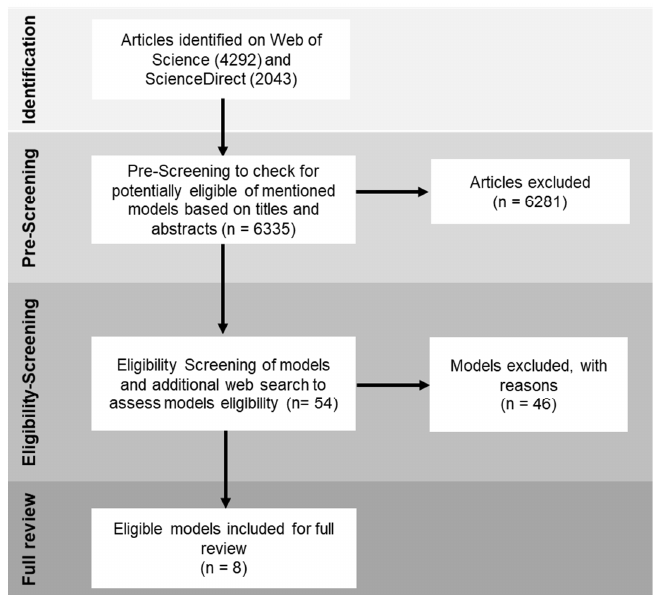
Figure 1. Flow chart of the methods used to identify, assess the eligibility of models and their inclu- sion/exclusion from full review .